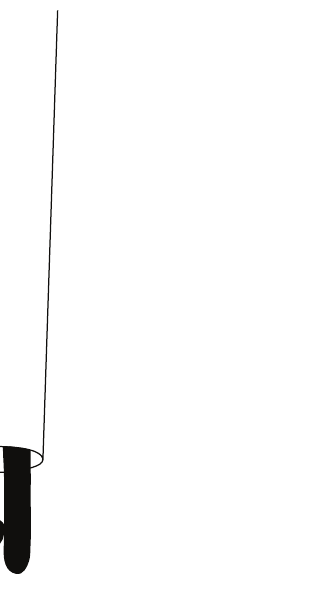
Figure 2: Interference fit guide wires. A non-tipped guide wire is passed beside a ball-tipped guide wire through the distal tip of the nail, and then the ball-tipped guide wire is pulled back to extract the nail.